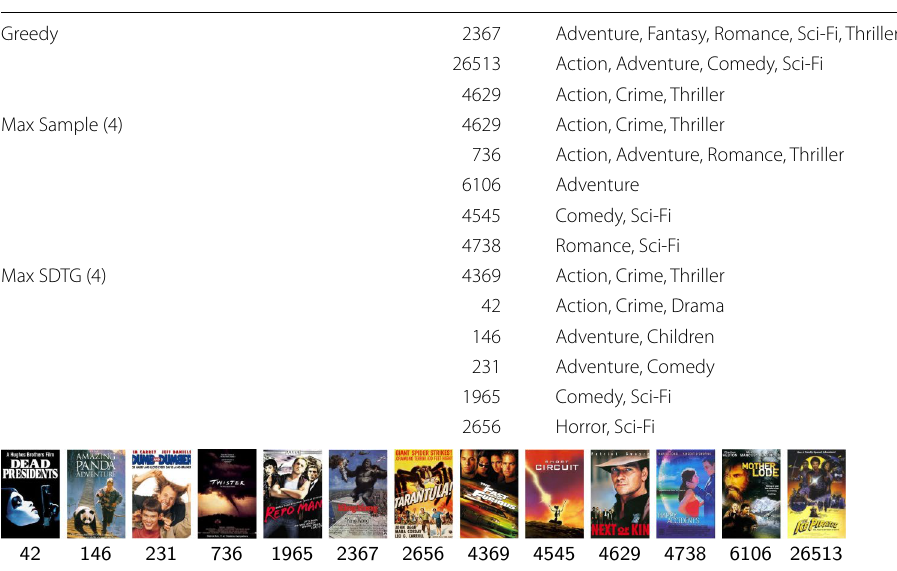
Table 1 Movies recommended by different algorithms, m g = 2